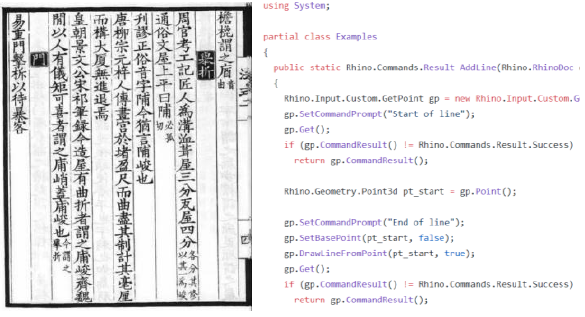
Figure 1. Ying Zao Fa Shi (left) and code format